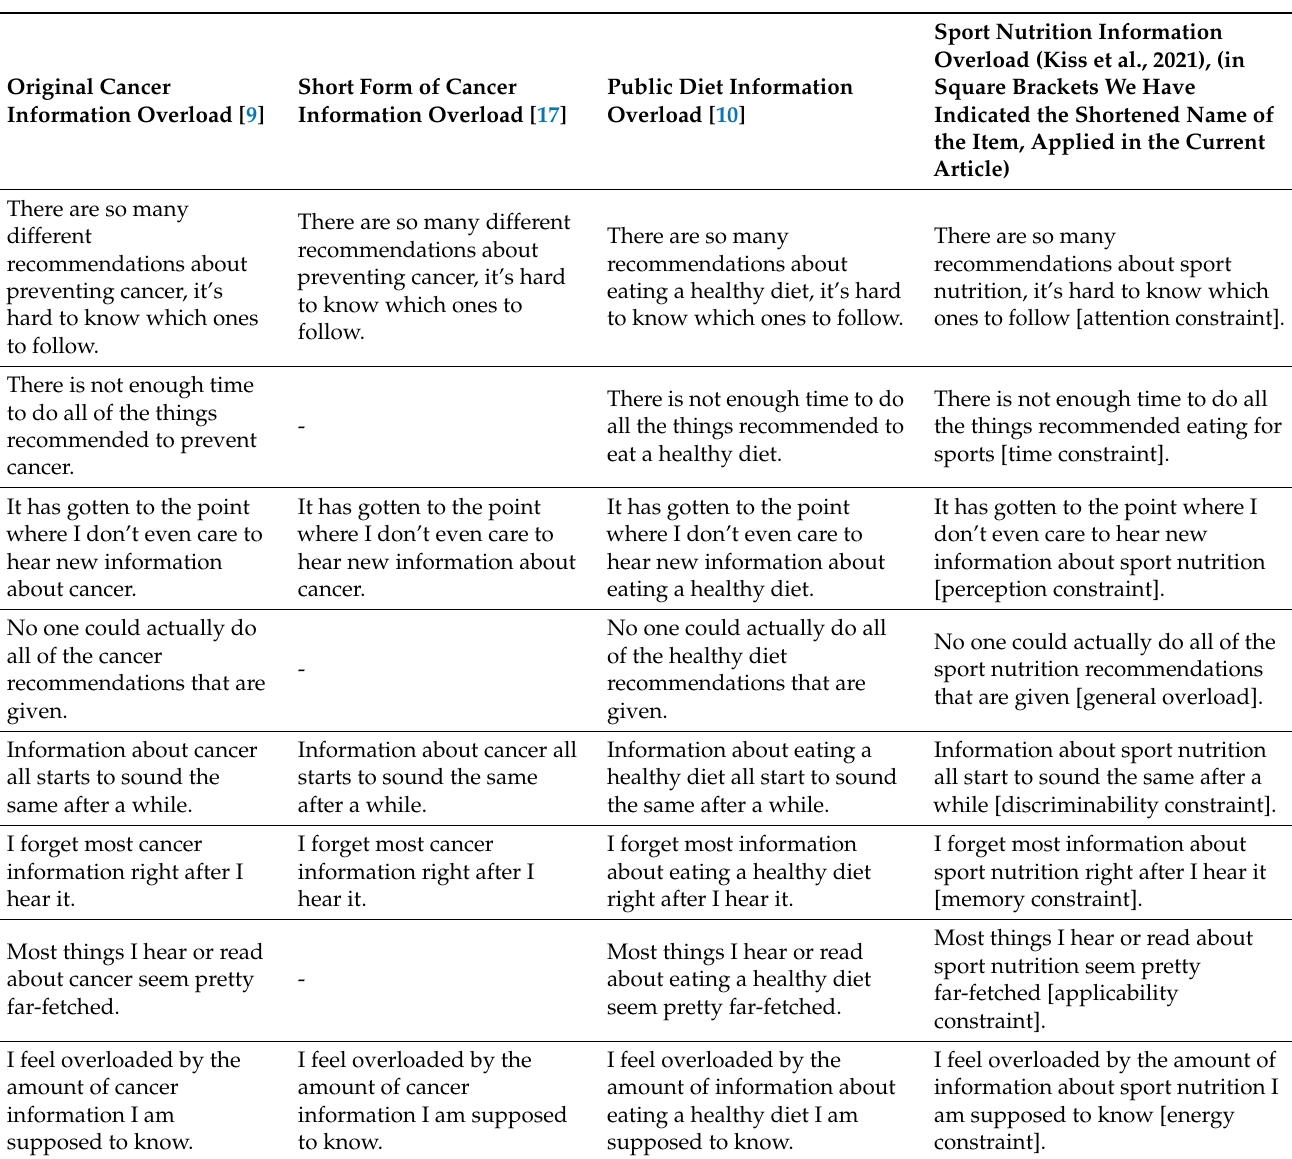
Table 1. Information overload scale for different focus